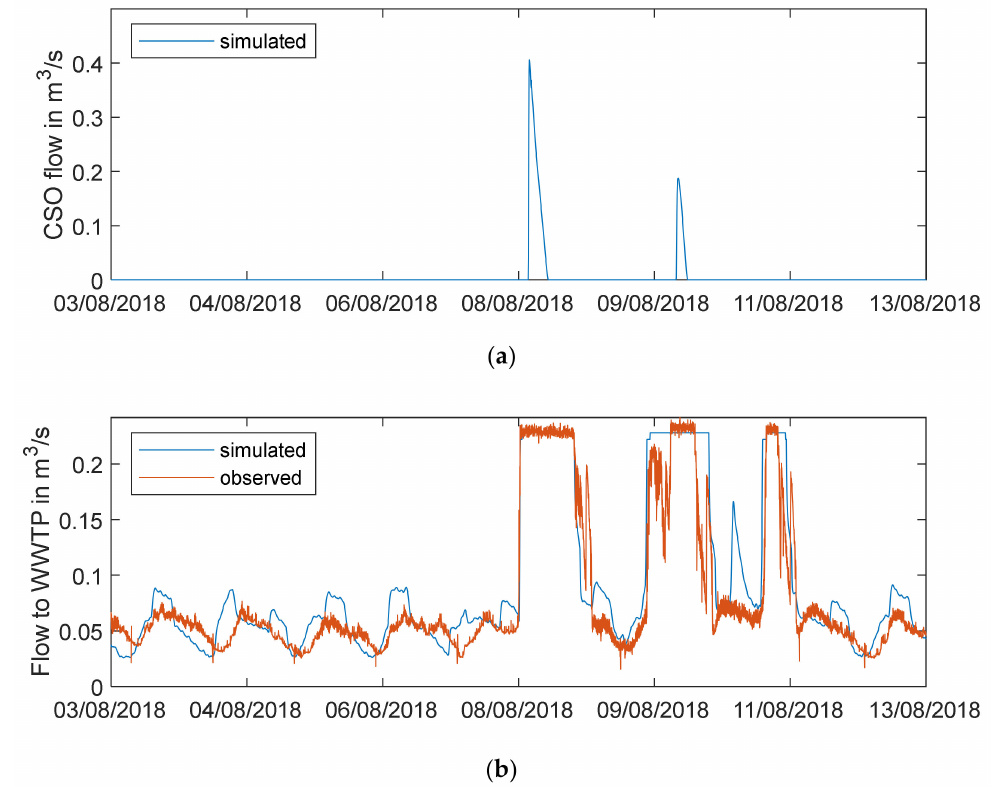
Figure 2. Example of simulated CSO spill flows time series ( a ) and verification of modeled sewer system outflow with registered WWTP inflow ( b